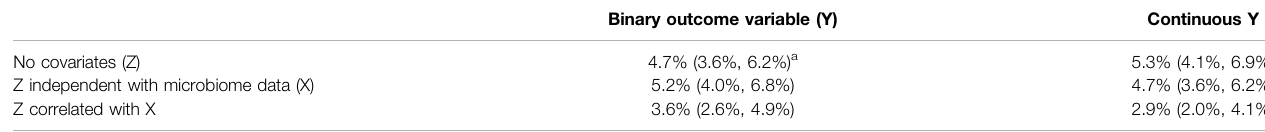
TABLE 1 | Estimated type I error rate of the random forest test